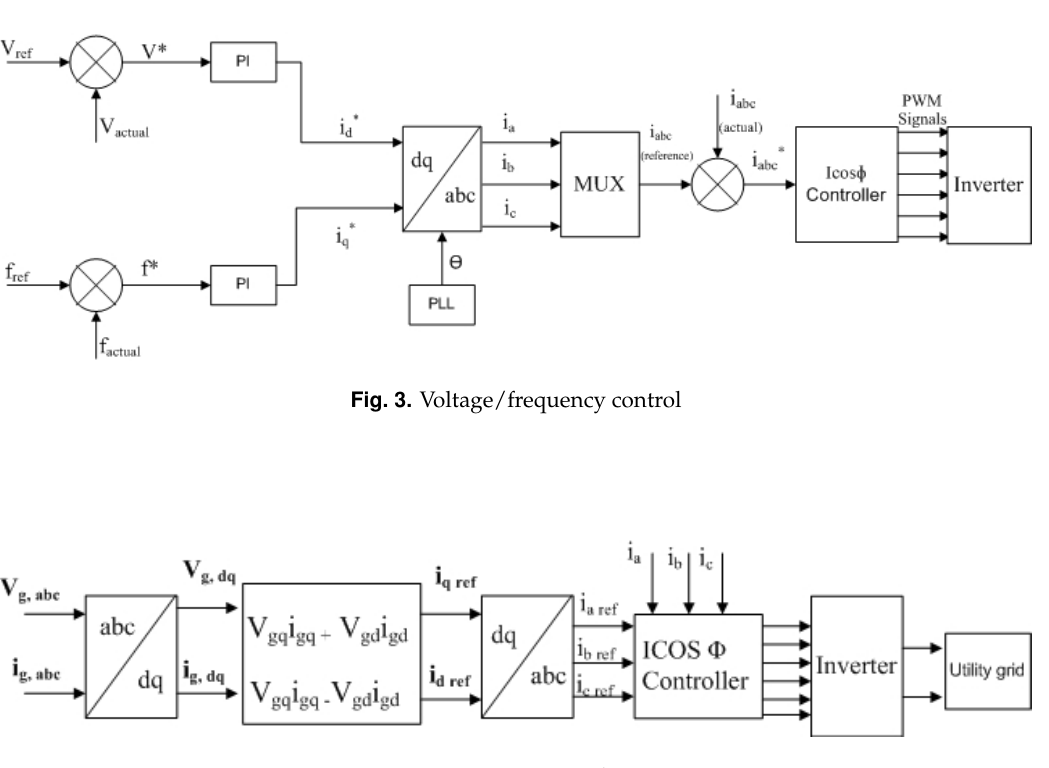
Fig. 4. PQ Control